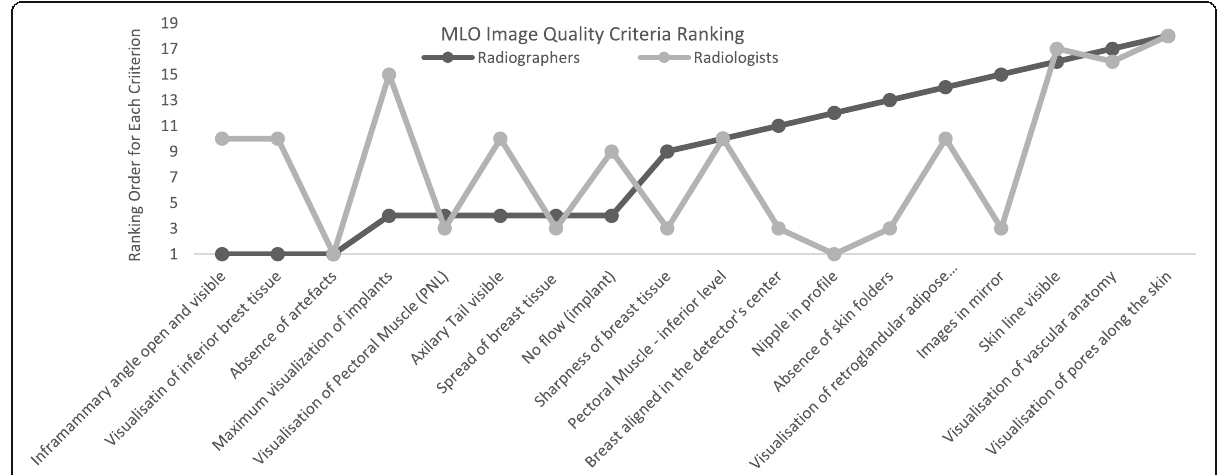
Fig. 1 Rankings attributed to image quality criteria used to assess mediolateral oblique (MLO) images by radiographers and